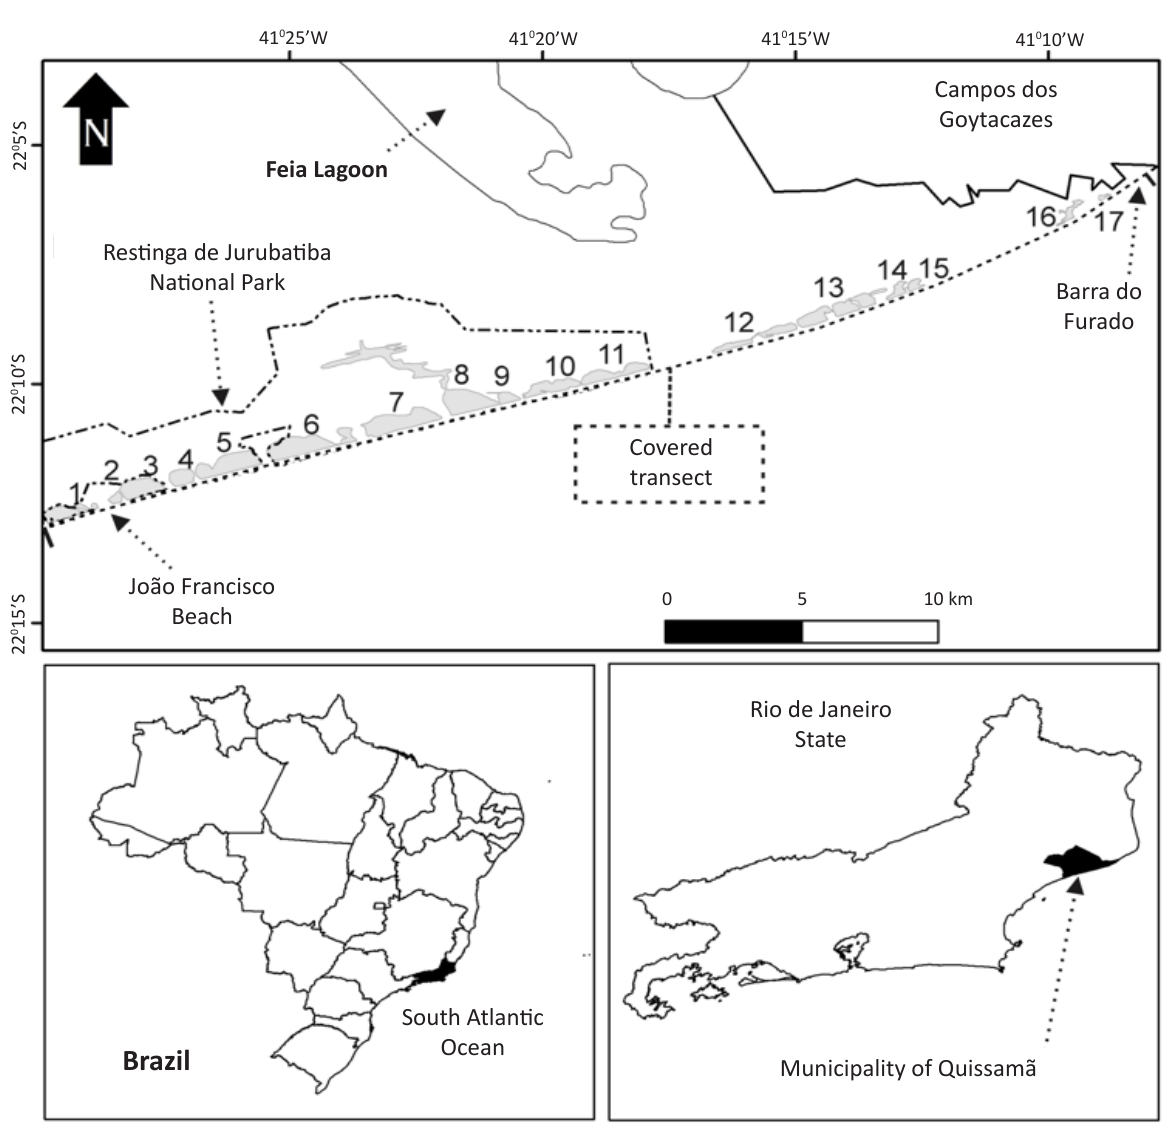
Figure 1. Location of the study site in northern Rio de Janeiro State, Brazil. Indication of the coastal lagoons adjacent to the shoreline. (1) Garças; (2) Piripiri I; (3) Piripiri II; (4) Maria-menina; (5) Robalo; (6) Visgueiro; (7) Pires; (8) Preta; (9) Barrinha; (10) Casa Velha; (11) Ubatuba; (12) Carrilho; (13) Canema; (14) Carvão, (15) Chica, (16-17) São Miguel. The dotted line indicates the covered